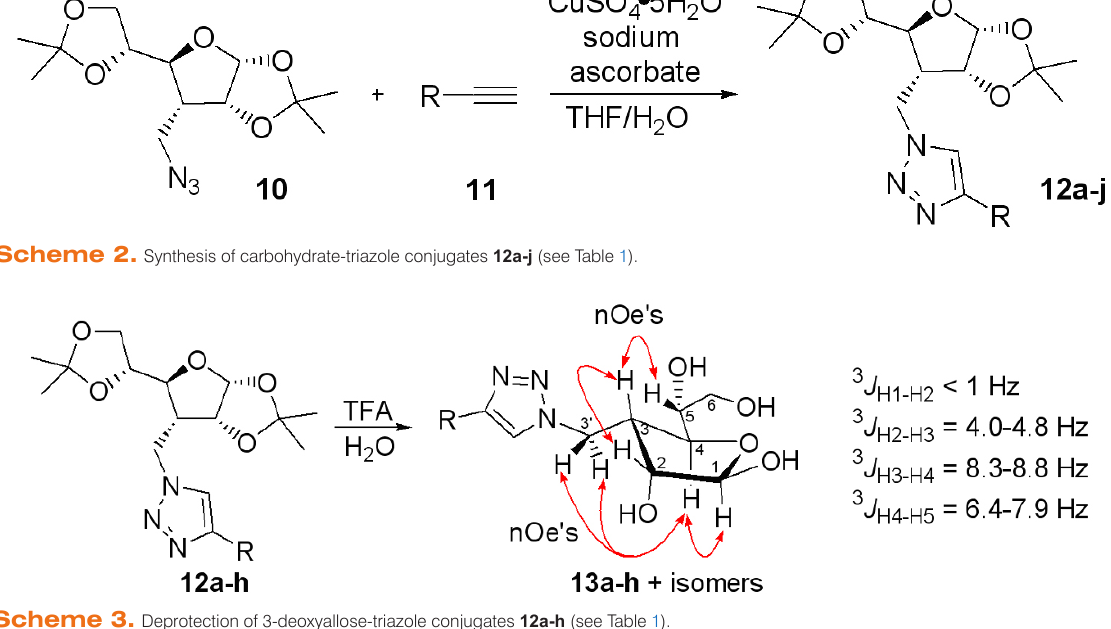
Table 1. Synthesis of protected ( 12a-j ) and deprotected ( 13a-h ) 3-deoxyallose − triazole conjugates. Entry R Compound 12, Yield, % Compound 13, Total yield of process 12 → 13, (content of 13 in isomeric mixture,